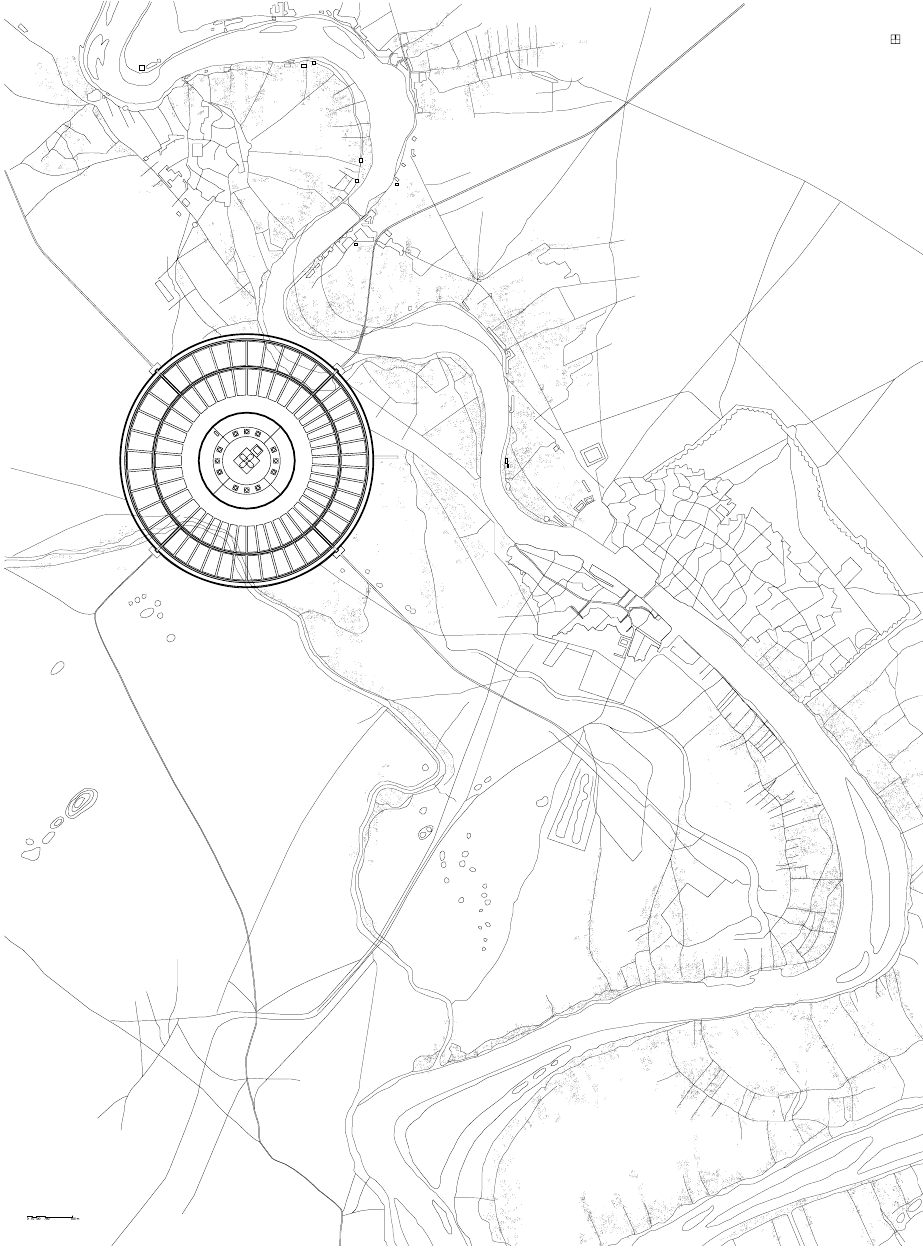
fig. 6. The City of Peace (Baghdad during al-Mansur) and its surroundings. Source : reproduced by the author after